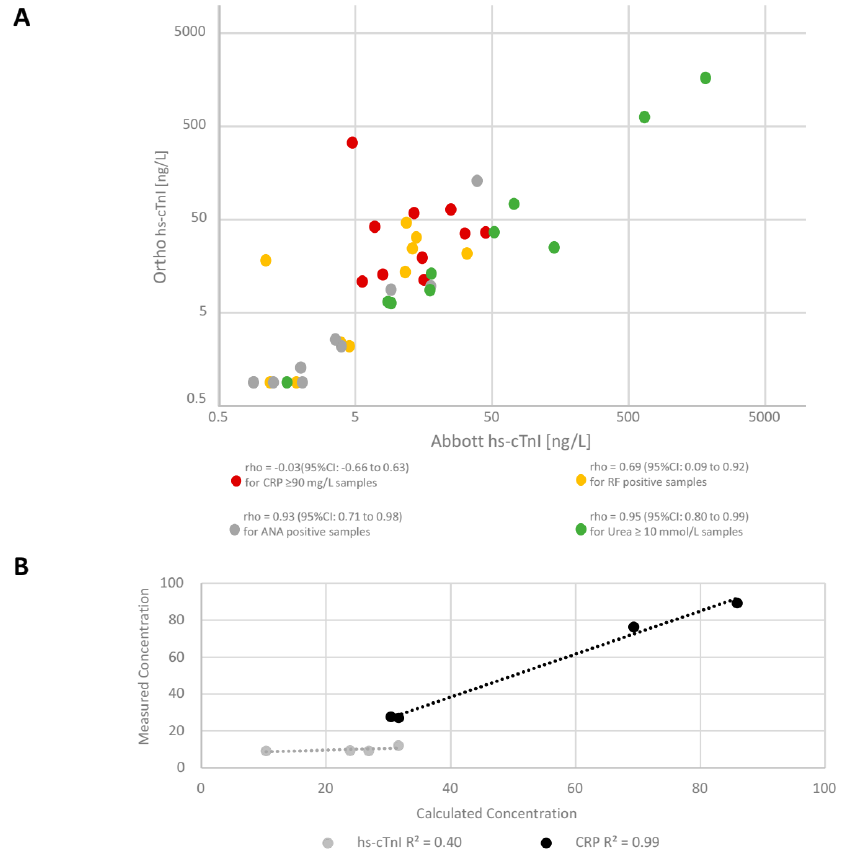
Figure 1. Correlation between Ortho hs-cTnI and Abbott hs-cTnI concentrations in four divergent biochemical groups of samples from patients ( A ). Recovery of Ortho hs-cTnI and CRP levels in samples with high concentrations of CRP diluted (1 in 5) with a low CRP sample ( B ). ANA: anti- nuclear antibody; RF: rheumatoid